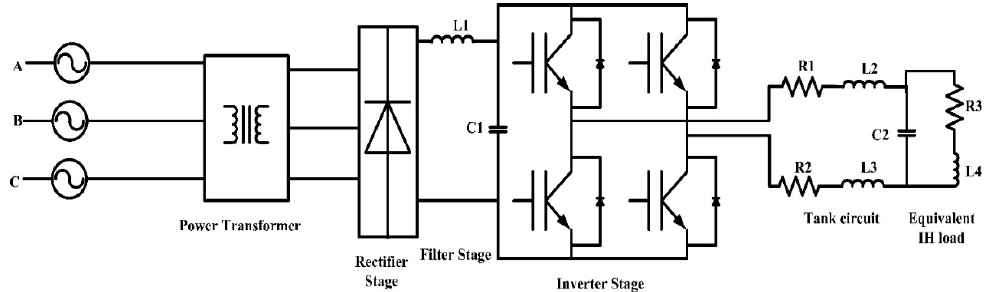
Figure 14. Circuit diagram of induction heating-based load.